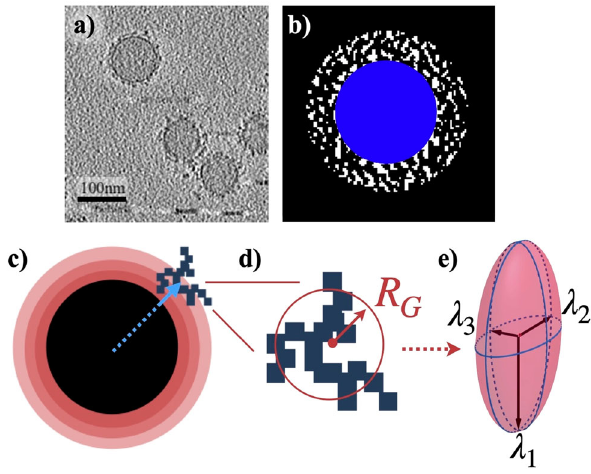
Fig. 9 De fi ning the physical characteristics of biomolecular corona. a A tomographic slice shows the BC surrounding the NPs (full series of 256 distinct cryo-EM images are provided in 10%Corona.rar and 50%Corona. rar fi les of the SI). The large circles represent spherical NPs. The BC is represented by black points forming clusters around the NPs. The horizontal black bar-like shapes in the bottom right corner of the image are artifacts of smaller gold NPs (used for focusing purposes) that are used to measure the scale of the image. b A binarized image showing the BC (white) surrounding the NP (blue). c The space around the NP is divided into spherical shells. The blue arrow points to the center of the cluster. The position of each cluster was determined according to where its center is located among the various shells. d A schematic representation of an arbitrary cluster. The size of the cluster was characterized by a sphere with a radius of gyration R G . Here we show a 2D representation. e The eigenvalues of the gyration tensor are represented with the radii of a hypothetical ellipsoid that best fi ts the The difference in the size of the corona between the two samples